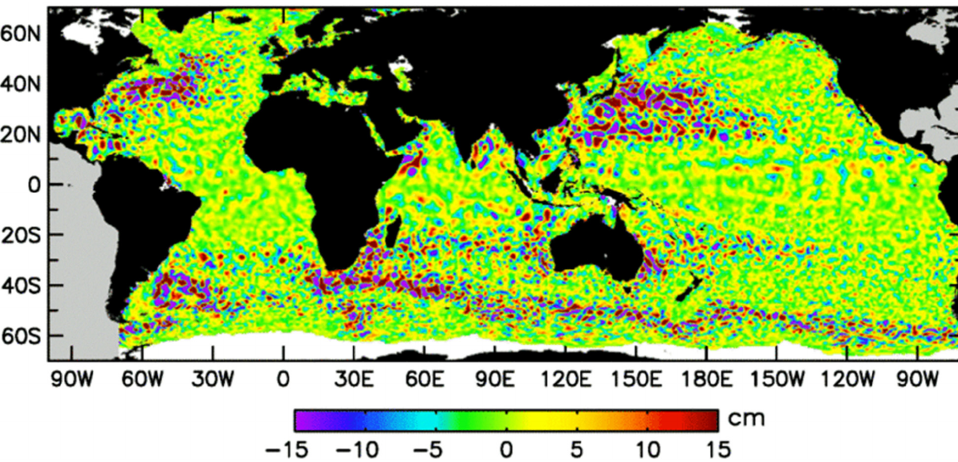
Figure 33. A meridional transect across the Pacific Ocean plotting zonal current speed; rapid speed changes are evident at some latitudes [119].